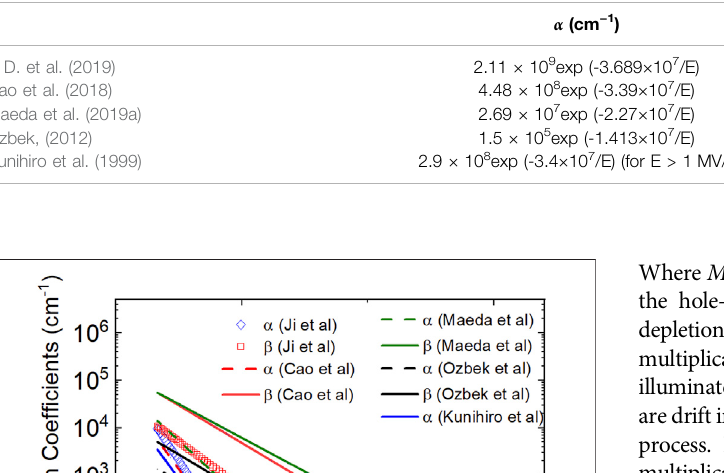
TABLE 3 | Estimated impact ionization coef fi cients in GaN.